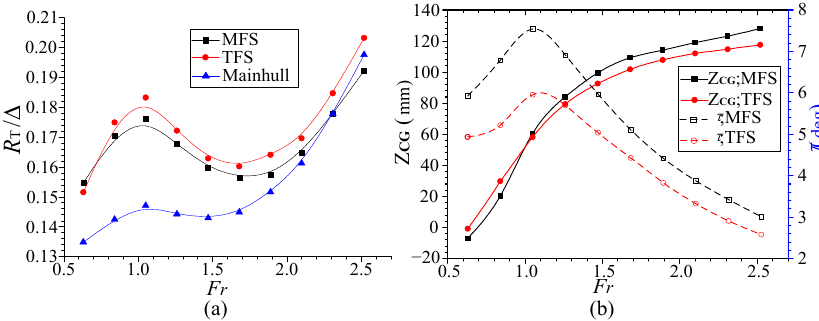
Figure 22. Change in total resistance and sailing attitudes with speed when L cg /L m = 0.38: ( a ) total resistance; ( b ) sinkage and trim angle. resistance; ( b ) sinkage and trim angle. F r = 0.84 Inside